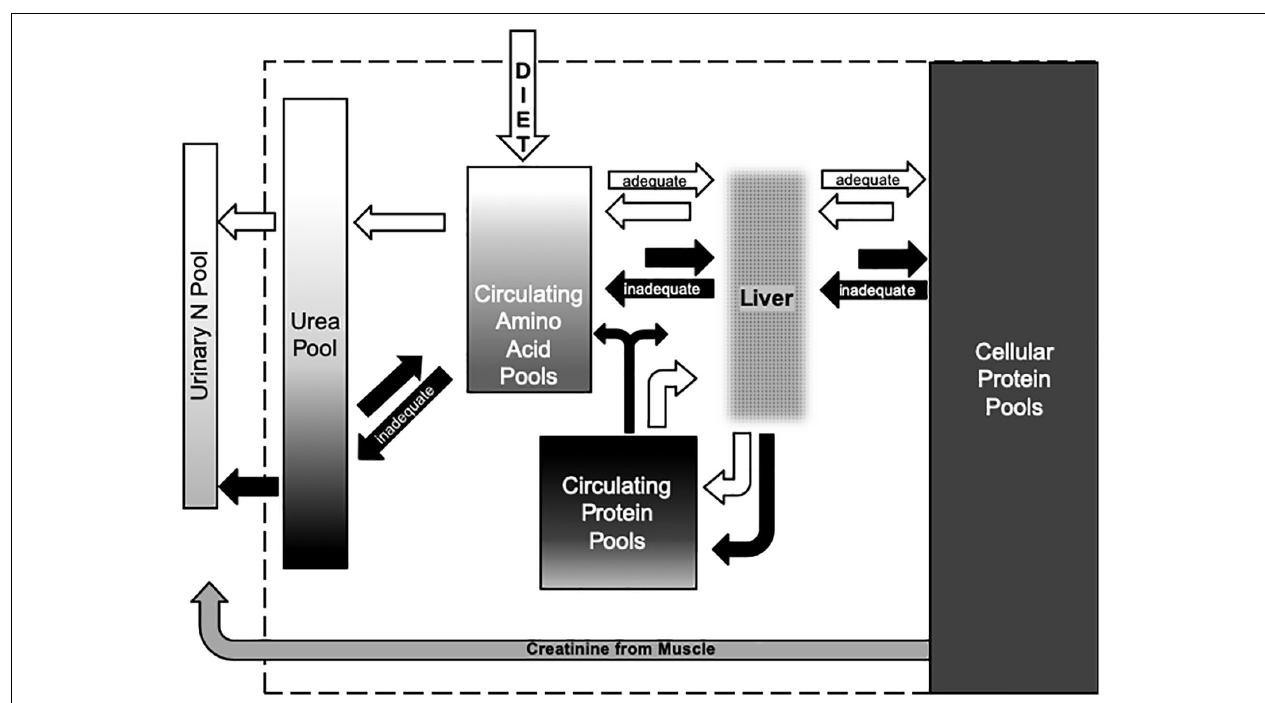
FIGURE 5 | Conceptual model of the flows of N among metabolic pools in the body and the excretion of N in urine from female ungulates during winter. White arrows indicate flows at adequate N balance when dietary N intake is at or above the requirements for maintaining the body and investing in reproductive tissues during winter. Black arrows indicate inadequate N balance when body N is mobilized to sustain body function and limit reproductive investment. Dietary N is absorbed as amino acids that enter the portal vein to the liver where the flow of essential and non-essential amino acids that are released into the hepatic vein are integrated with flows recirculated from the body to the liver via the hepatic artery. The liver also synthesizes serum proteins such as albumens from dietary and recirculating amino acids. Turnover of cellular proteins in other organs and muscles add and remove protein and amino acids from the circulation. Breakdown of circulating and cellular proteins to amino acids for energy substrates such as glucose results in oxidation of N to form urea that is excreted from the body when dietary N supplies are high (positive N balance) but conserved by recycling when supplies of N are low (negative N balance). Shading within the boxes that represent each pool indicates the range of δ 15 N values. The large pool of N in cellular proteins of muscles and blood cells has δ 15 N values that are higher than those of the diet. Values for δ 15 N in amino acids are intermediate to the diet and cellular proteins whereas values for serum proteins often exceed those of blood cells. Values for δ 15 N in urea vary with the source of N – values are lowest when amino acids from the diet are oxidized and highest when those amino acids are released from catabolism of proteins in cells or sera. Nitrogen excreted in urine includes urea and other metabolites such as creatinine – an energy substrate from muscle with δ 15 N values that reflect the values of proteins in those